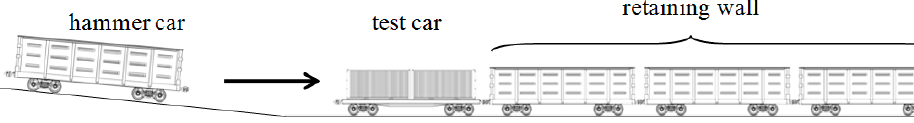
Figure 13. Scheme of car collision.